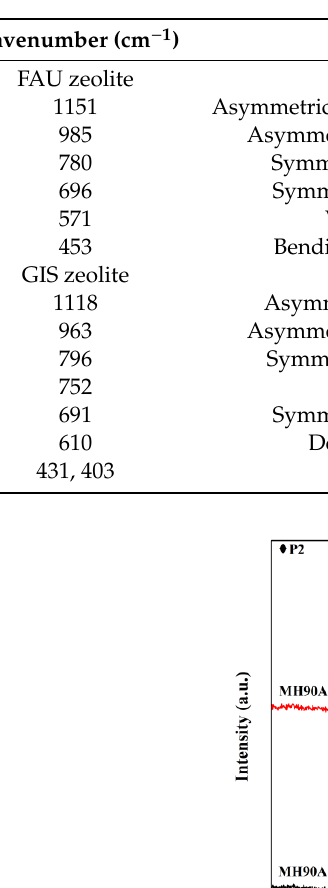
Table 2. Band assignment of FTIR spectra of MH90 (FAU) and MH90A150 (GIS) samples.